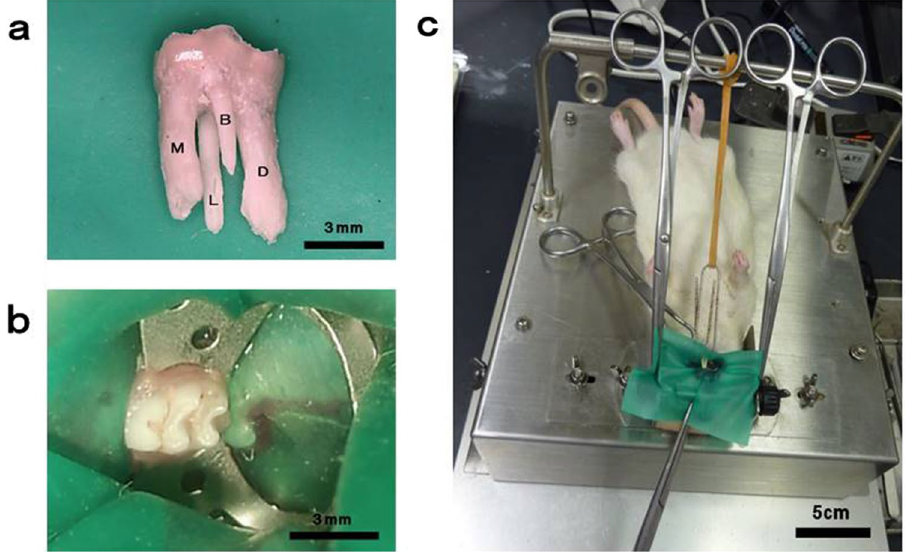
Figure 2. Rubber-dam isolation of the rat mandibular molar. ( a ) Rat mandibular first molar with four roots and a crown with a mesiodistal diameter of approximately 3 mm. ( b , c ) Isolation of the tooth with a custom-made rubber-dam